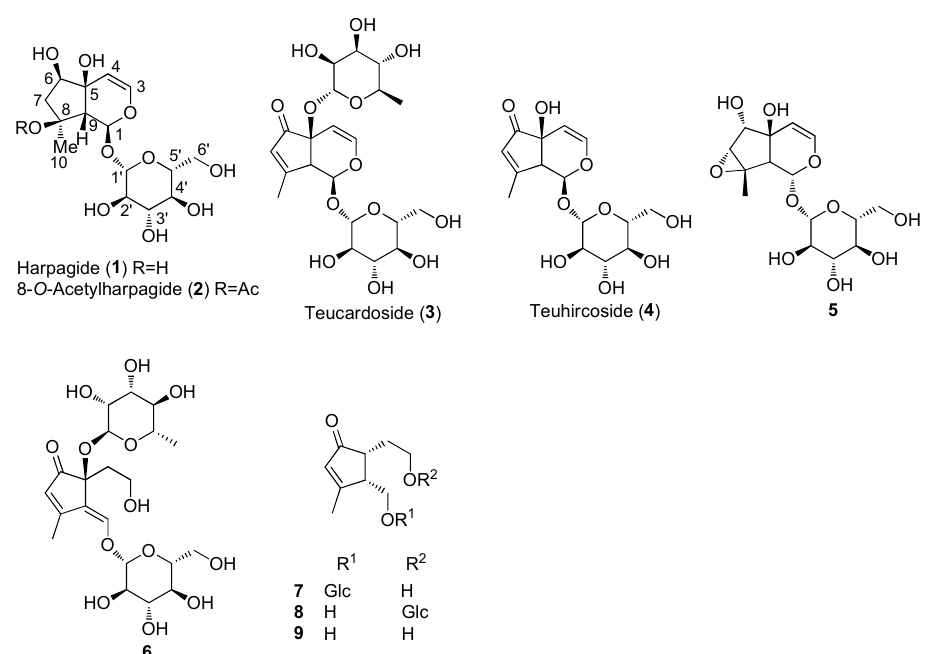
Figure 2. Representative iridoids and iridoid glycosides isolated from Teucrium chamaedrys, Teucrium oliverianum and Teucrium polium.